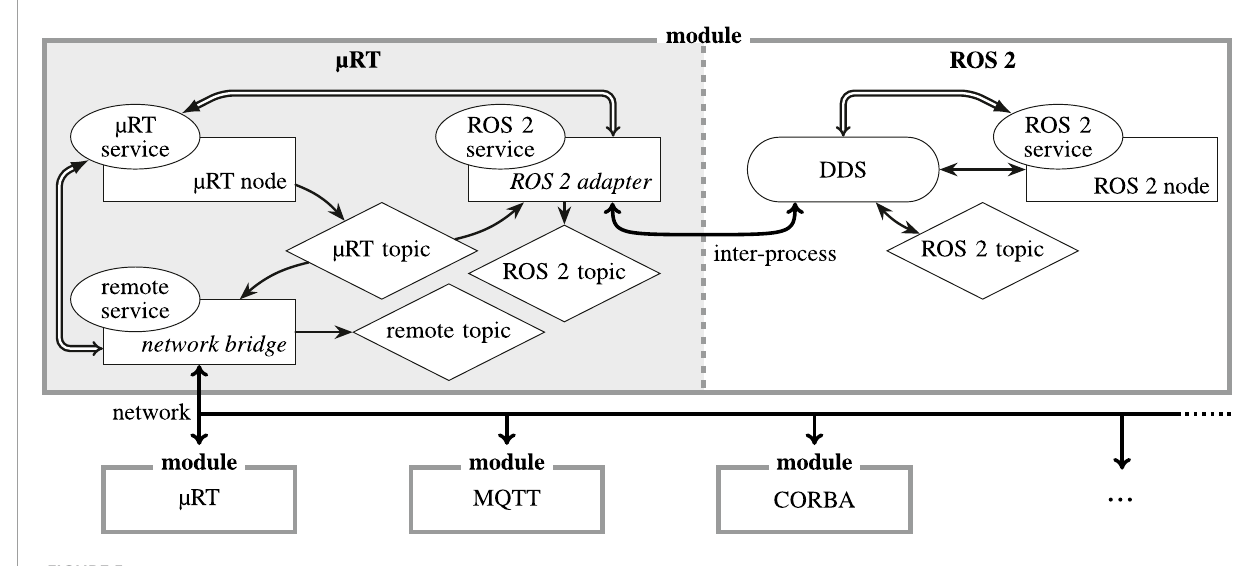
FIGURE 5 Example setup in a complex system with multiple hardware modules and various middlewares (only the most relevant interactions are depicted). Publish–subscribe interaction is indicated by , represent RPC interactions, and depict network and inter-process communication. µRT’s transport agnostic communication is realized by bridge nodes , such as “ network bridge” and “ ROS 2 adapter” in the figure. While the former has to (de)serialize messages and requests from/to a common format as defined for that network channel, the latter needs to translate them according to the employed DDS. The bridge nodes can provide an arbitrary subset of the remote/foreign topics and services they connect with to the local µRT instance and vice versa . If the network supports real-time communication (e.g., CAN), all modules running µRT form a distributed, real-time capable union in which network communication is completely transparent to all nodes (except bridge nodes , of